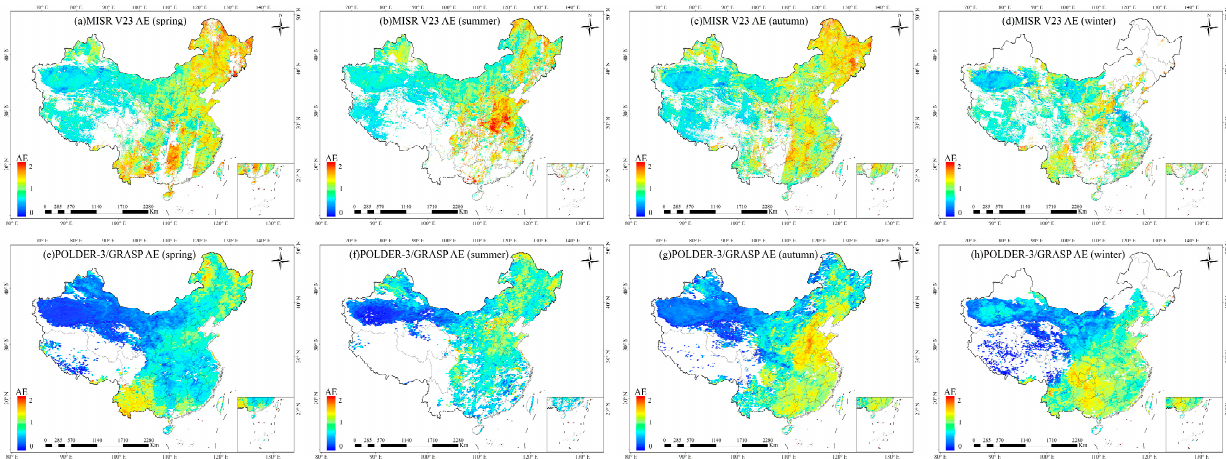
Figure 10. Distributions of seasonal mean AE in 2012 from MISR V23 at 500–860 nm (( a ) spring; ( b ) summer; ( c ) autumn; ( d ) winter) and POLDER-3/GRASP at 443–865 nm (( e ) spring; ( f ) summer; ( g ) autumn; ( h ) winter).